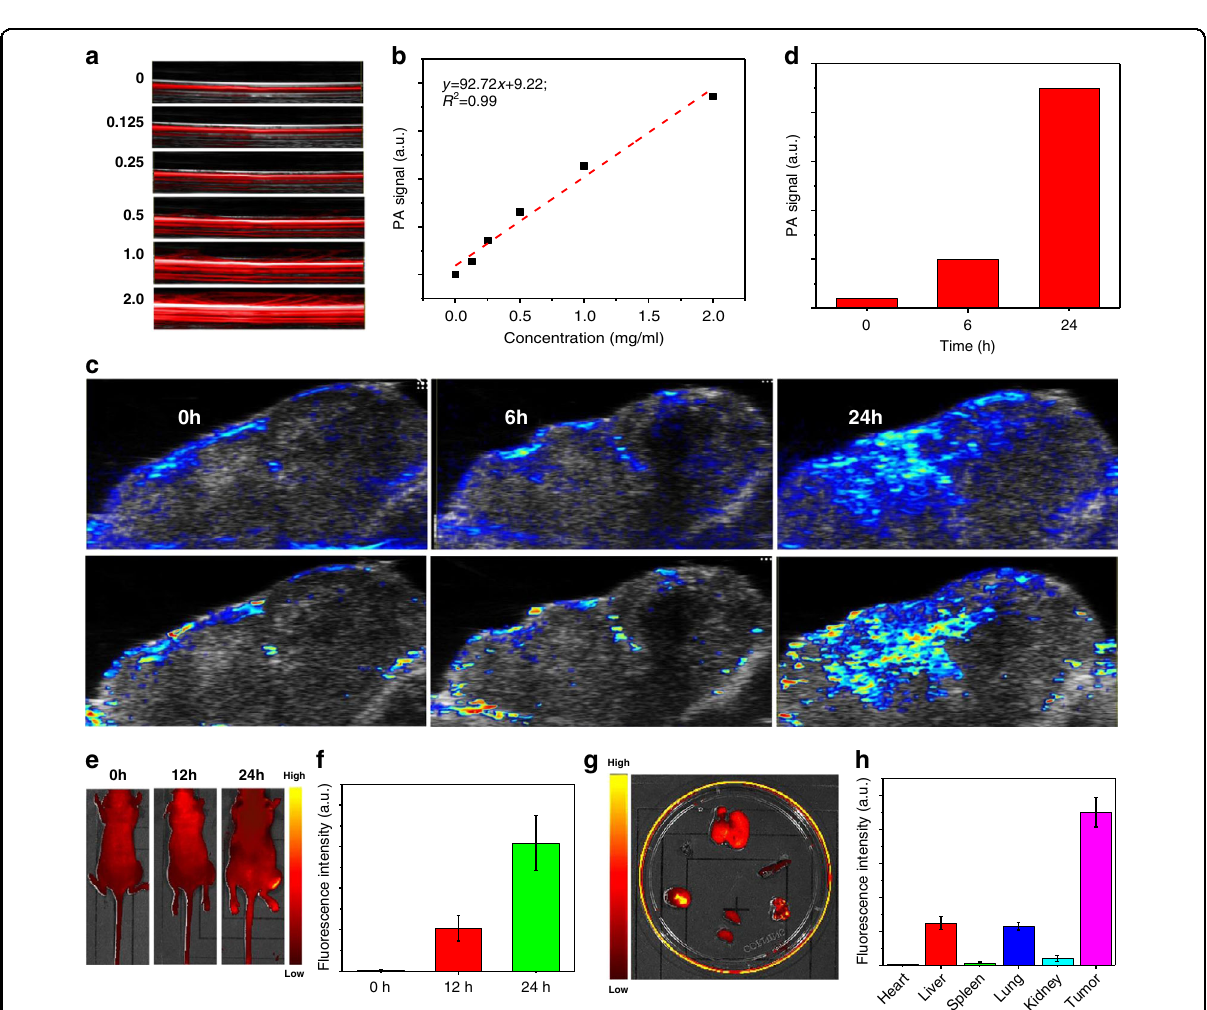
Fig. 8 Multi-modal in vivo imaging and bio-distribution of B@PDA. a In vitro PA images of B@PDA vs. concentration (0, 0.125, 0.25, 0.5, 1, and 2 µg µl − 1 ). b PA images of B@PDA vs. concentration (0, 0.125, 0.25, 0.5, 1, and 2 µg µl − 1 ). c PA aqasximages in tumor site at time points of 1, 6, and 24 h post-injection. d Quantitative calculation of PA signal in PA images ( c ). e In vivo fl uorescence images in tumor site of Cy5.5-labeled B@PDA during 24 h. f Quantitative calculation of Cy5.5-labeled B@PDA locating in the tumor site. g Fluorescence images of major organs at 24 h post- injection. h Quantitative biodistribution of B@PDA in BALB/c